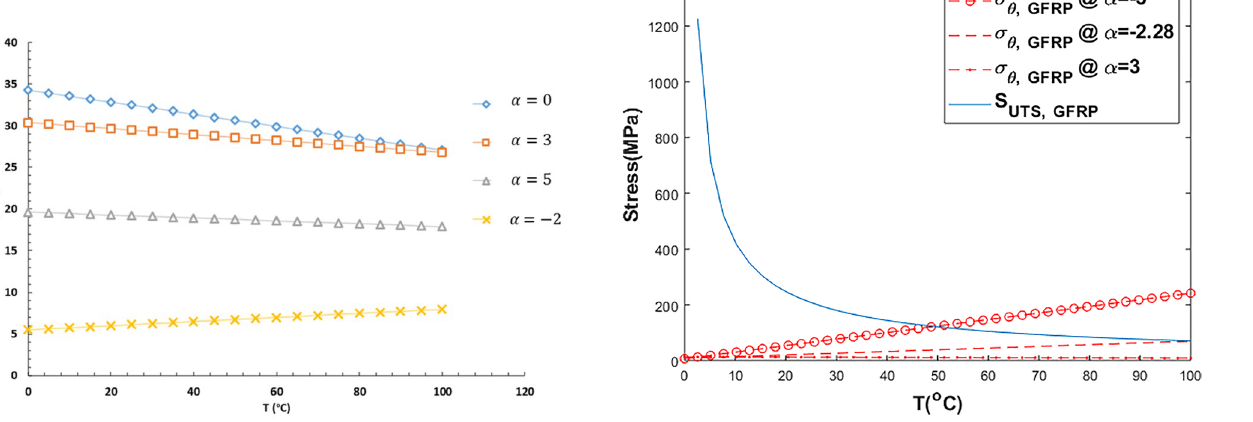
Fig. 14 Burst pressure in the case of the pipe subjected to the pro- portional loading